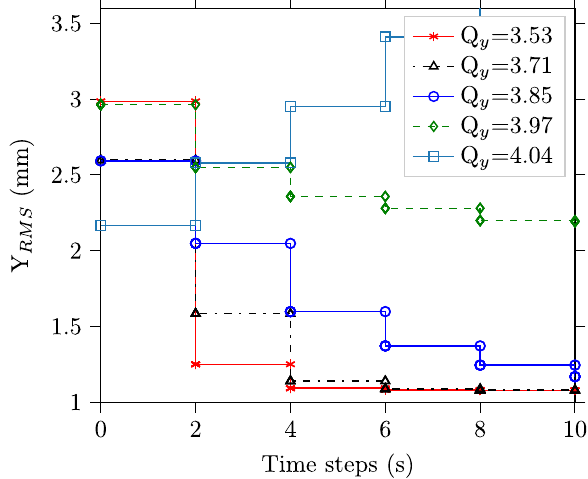
FIG. 12. Measured RMS of the closed orbit in y -plane of COSY synchrotron for different ORMs used for the corrector settings calculation while keeping the machine settings fixed for a tune of